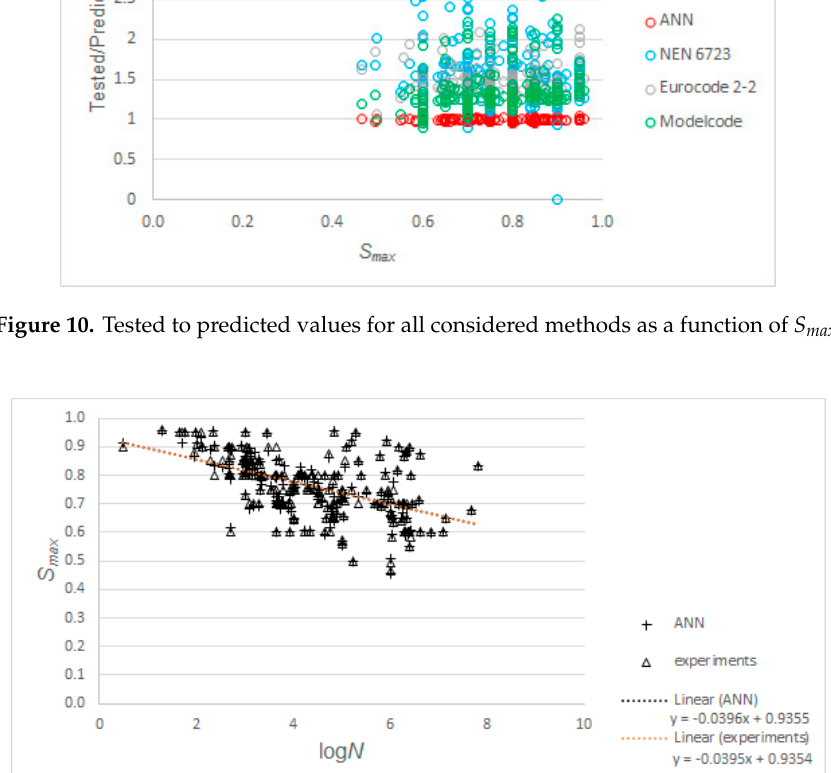
Figure 11. Comparison between Wöhler curve resulting from experimental data and from ANN-based predictions.